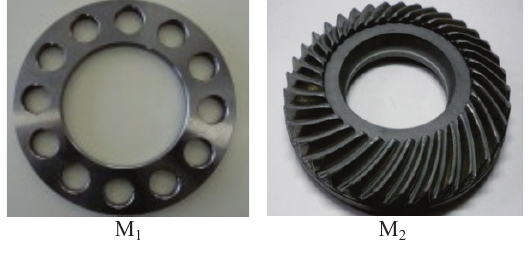
Fig. 3. Designated parts. Fig. 4 shows the logical structure of the current production line for part types M and M . This 1 2 production line mainly comprises seven